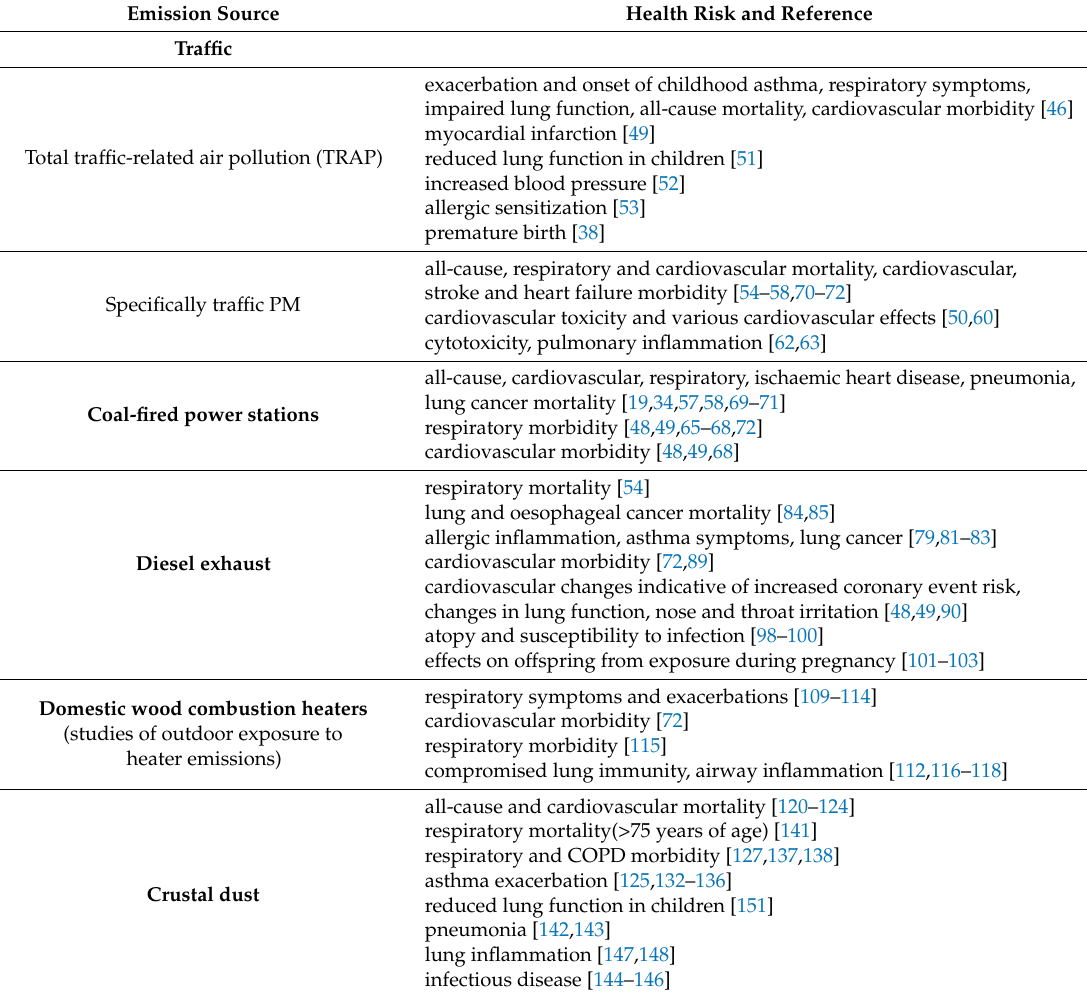
Table 3. Summary of PM emission sources and reported health and physiological/toxicity effects (physiological/toxicity effects includes animal